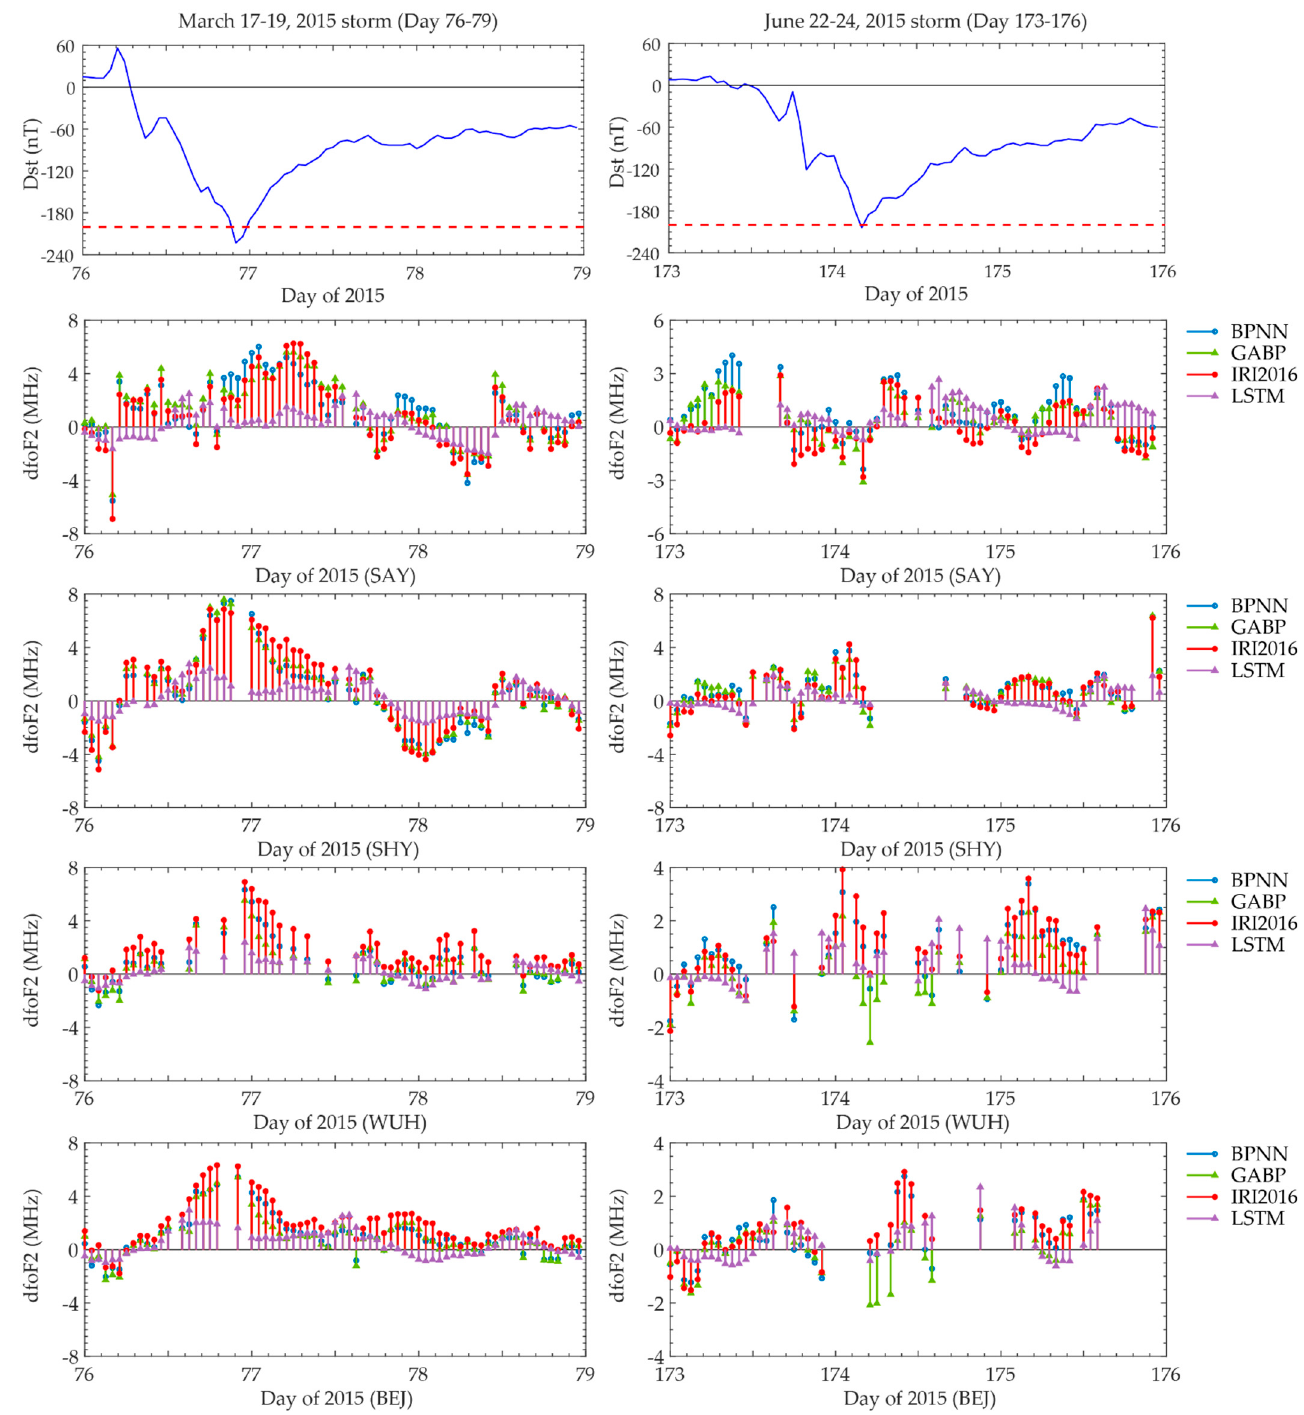
Figure 9. Absolute deviation of foF2 forecasting in Figure 8. The top panels show the variation of the magnetic Dst index during the two storms.